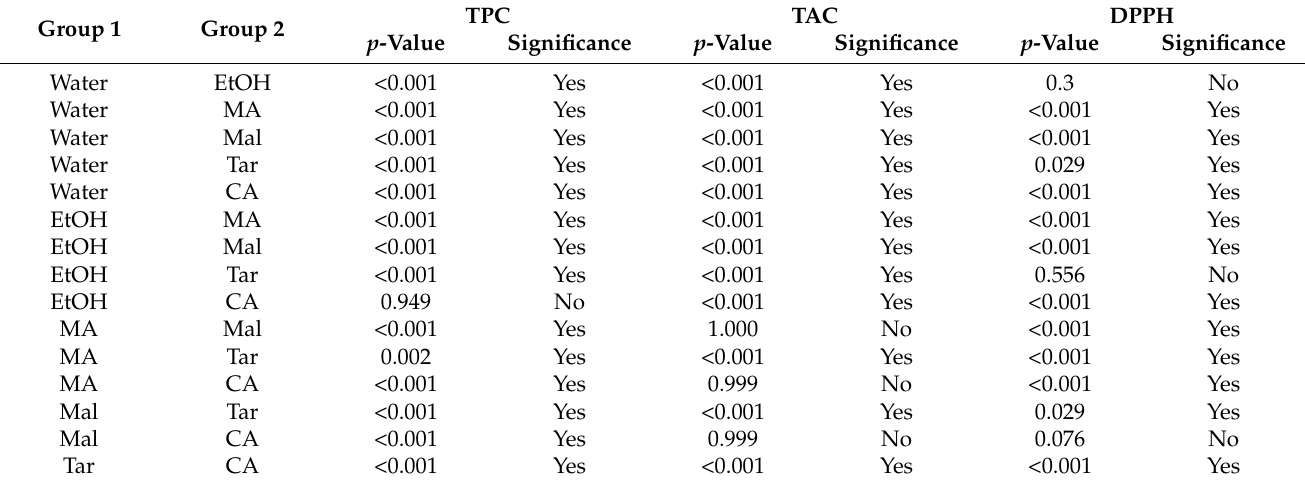
Table 1. Results of Tukey’s HSD test of estimation a statistically significant difference at p ≤ 0.05 between extraction efficiency of various solvents using parameters TPC, TAC and